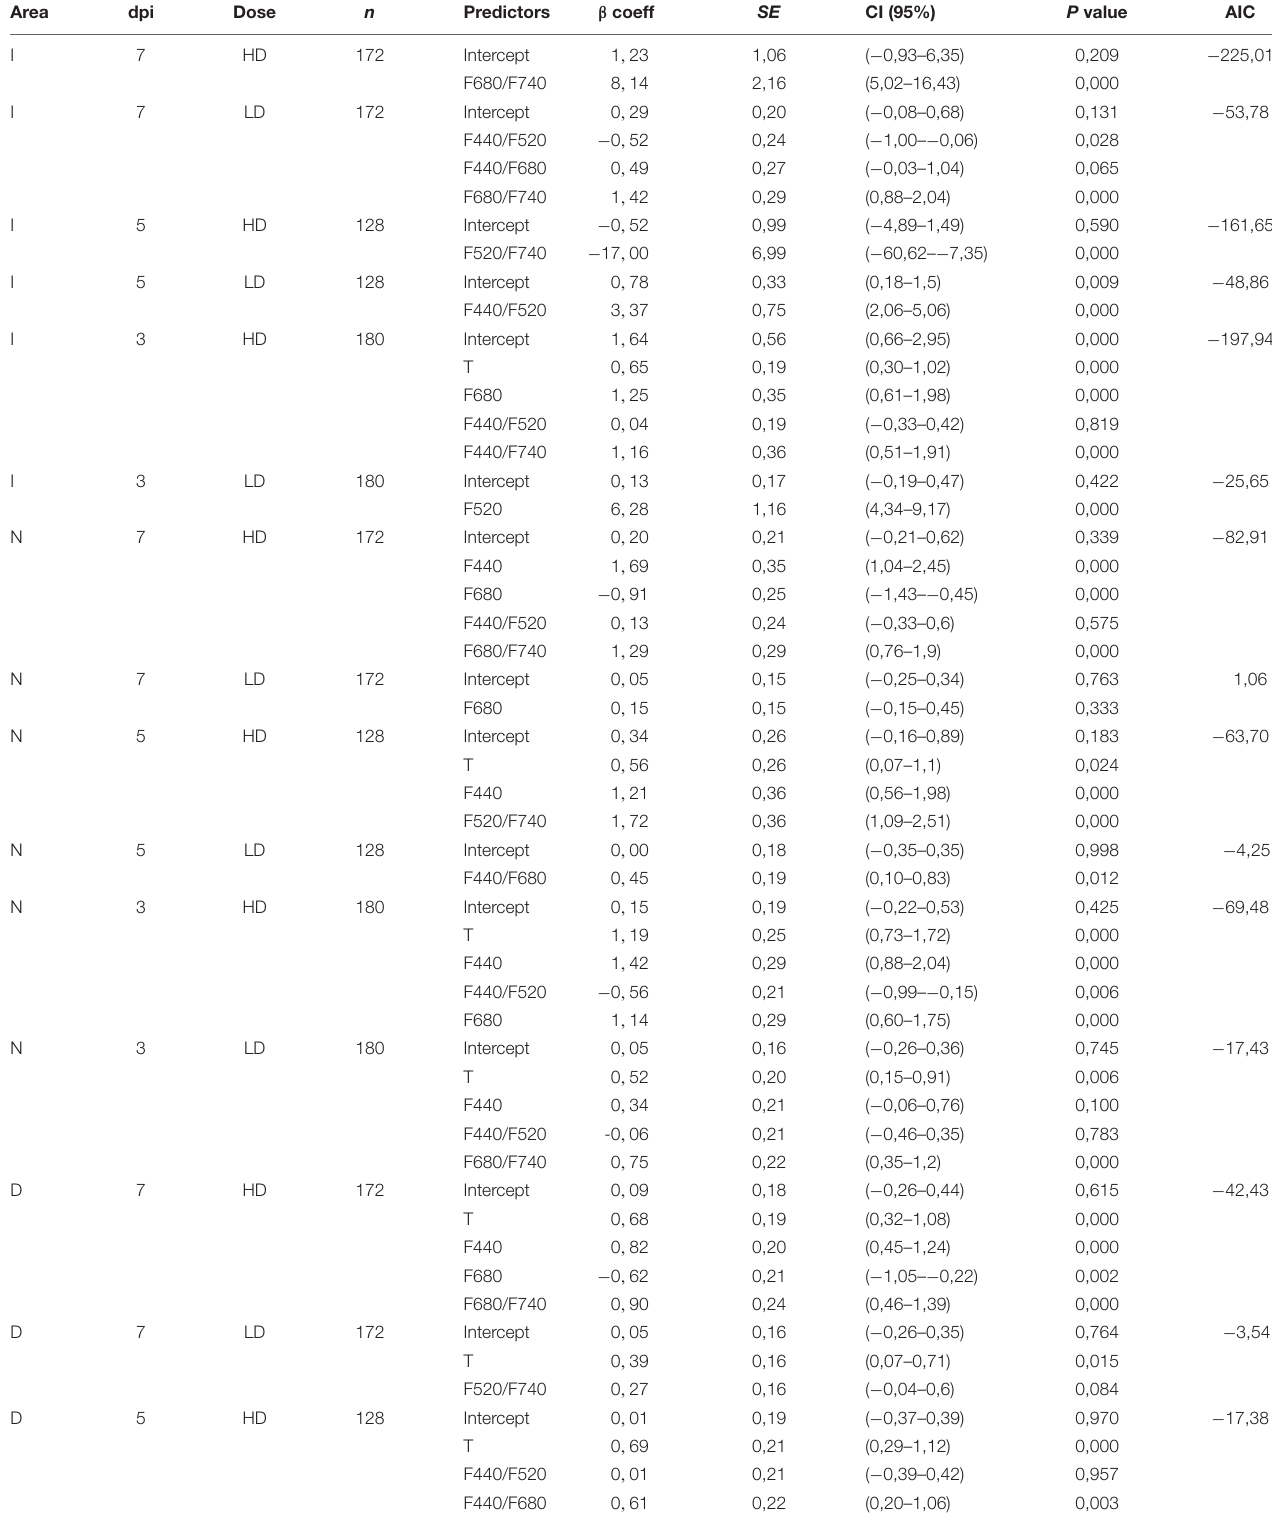
TABLE 1 | Best logistic regression fits for the prediction of healthy and Dickeya dadantii infected zucchini leaves.